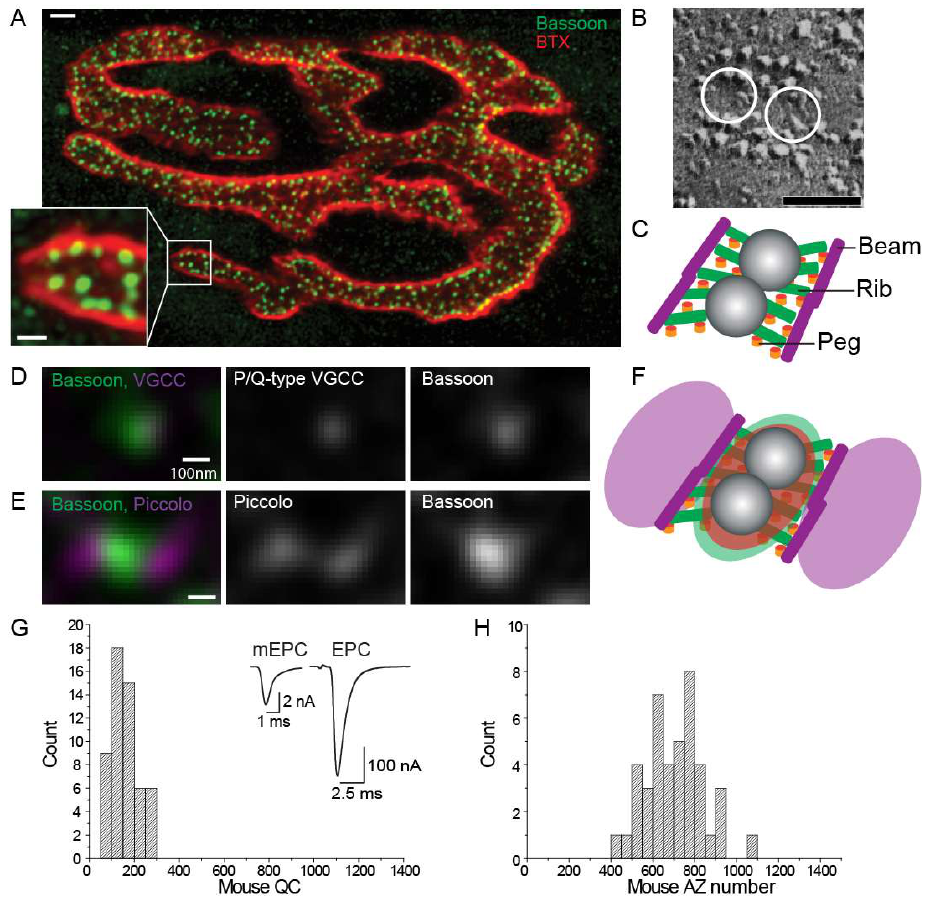
Figure 2. The structure and protein distribution of mouse NMJ AZs. ( A ) A mouse NMJ stained with Alexa-594 α-bungarotoxin (BTX; red) to demonstrate the shape of the NMJ and an Alexa-488 conjugated antibody to identify the bassoon protein the AZs (BSN; green). Inset shows an enlargement of one part of the NMJ to make it easier to visualize the distribution of AZs (green spots). Image adapted from [5]. ( B ) A freeze-fracture replica of an AZ from a mouse NMJ. The hypothesized locations of synaptic vesicles are superimposed as white circles. Scale bar = 50 nm. Adapted from [10,36]. ( C ) Diagram of a single AZ from a mouse NMJ based on electron microscope tomography data [36]. Diagram shows docked synaptic vesicles (gray spheres), along with AZ structures termed “pegs” (orange), “beams”